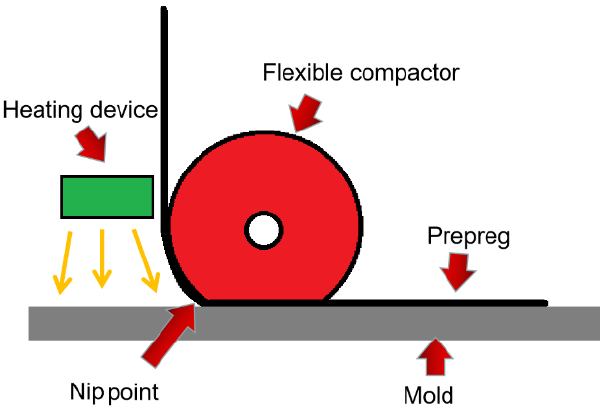
Figure 1. ThermosetAFP working process.